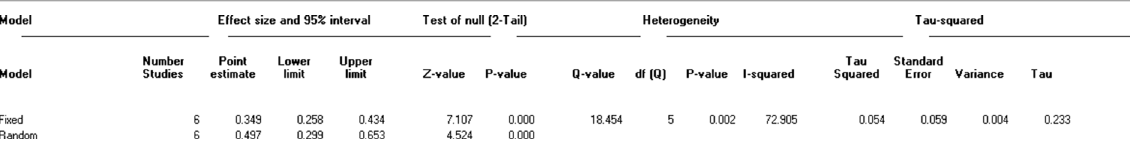
Fig. 5 Effect size model for heterogeneity estimated in nulliparous